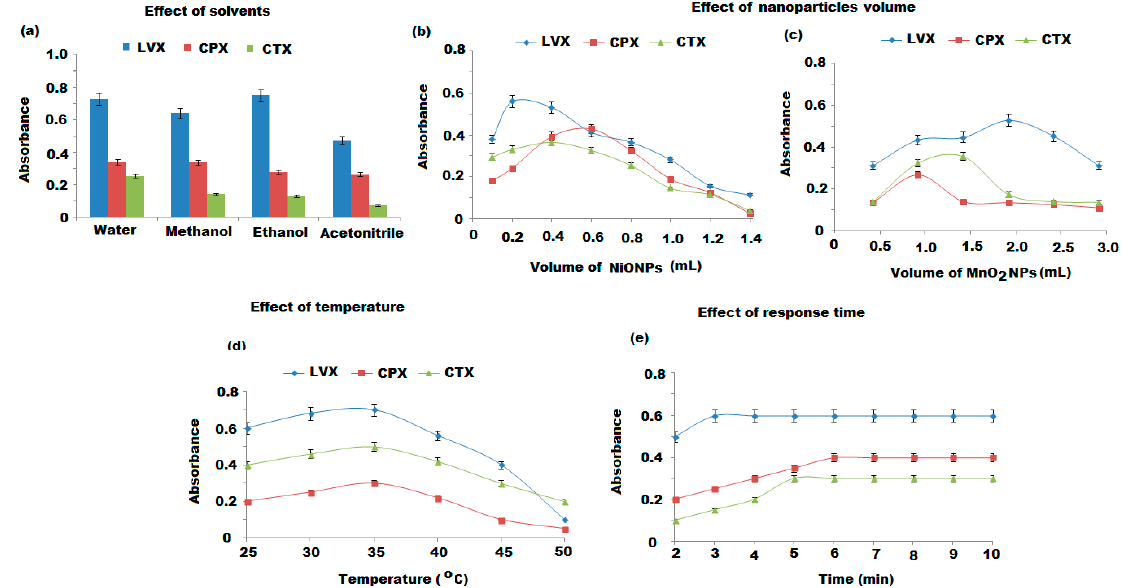
Figure 7. ( a ) Effect of solvents on the absorbance maxima of the three investigated drugs dissolved in different solvents and in the absence of nanoparticles, ( b , c ) effect of NiONPs and MnO 2 NPs volume, ( d , e ) effect of temperature 25–50 °C and effect of response time 2–10 min on the absorption of 10 µg mL − 1 of LVX, CPX, and CTX solutions in the presence of the corresponding nanoparticles as indicated previously.